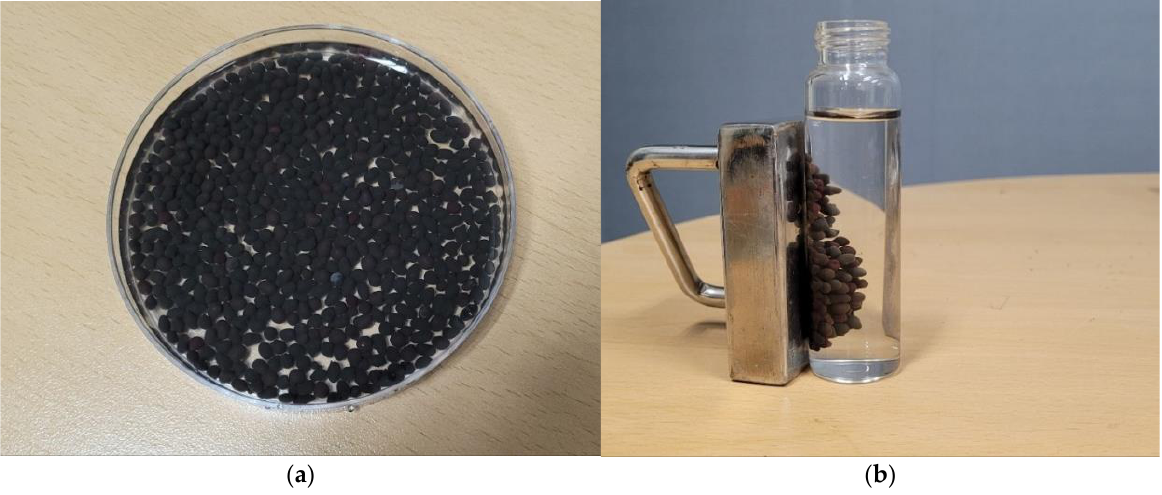
Figure 5. ( a ) A photo of WFD/SA-PEI and ( b ) photo to show magnetic properties of WFD/SA-PEI in solutions.